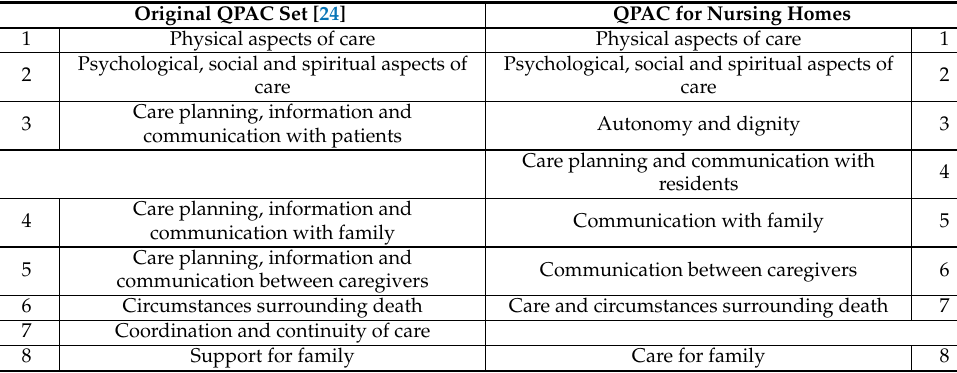
Table 2. Eight thematic domains for quality indicators.